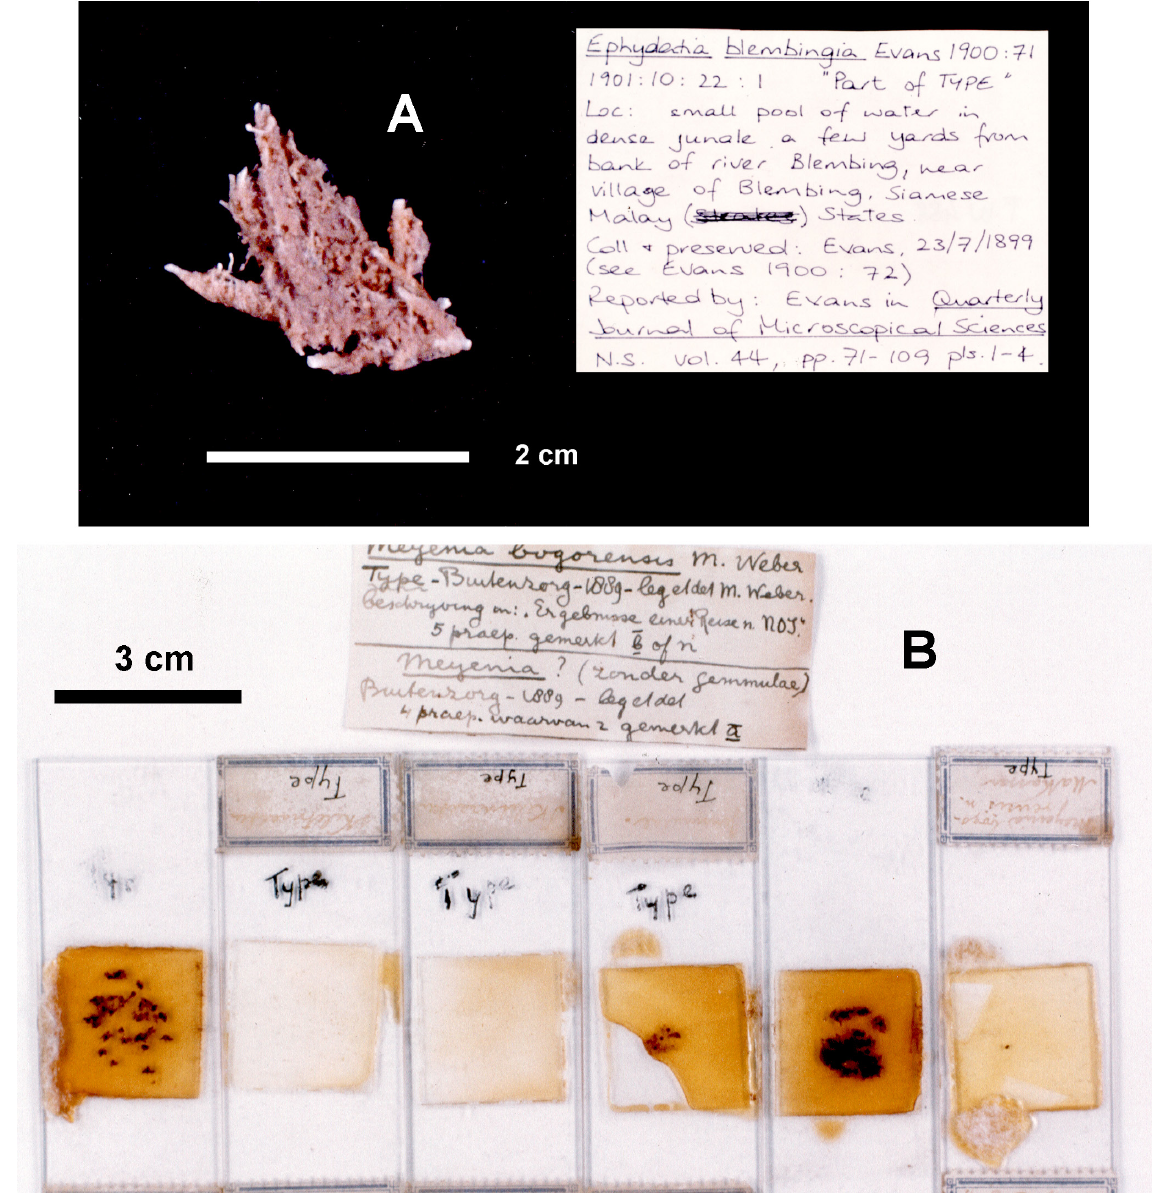
Fig. 9. A . Part of the type encrusting on a plant, 1901:10:22:1 of Ephydatia blembingia = Umborotula bogorensis , the Natural History Museum of London. B . Six slides ZMA POR 01551 representing the remains of the type material of Umborotula bogorensis preserved in the Institute for Systematics and Population Biology of the University